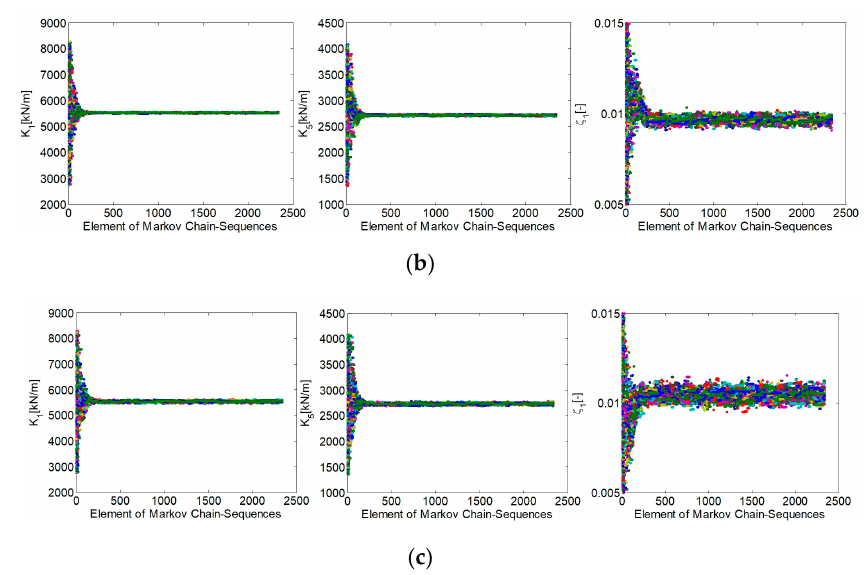
Figure 4. Generated samples for the three estimation parameters ( k 1 , k 5 , ζ 1 ): ( a ) Case 1: 0% noise + Full Outputs; ( b ) Case 2: 10% noise + Full Outputs; ( c ) Case 3: 10% noise + Partial Outputs.